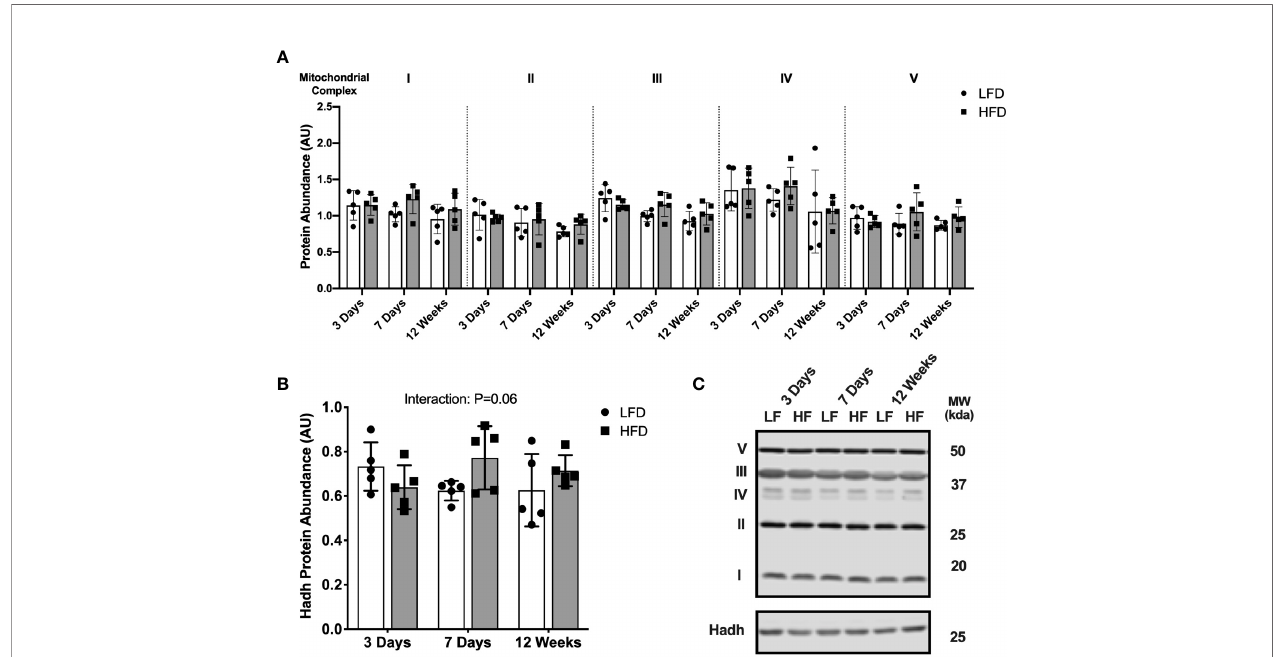
FIGURE 2 | Short-term high-fat feeding did not alter mitochondrial enzyme abundance. Immunoblotting of lysates from quadricep muscle collected after a 4-hour fast from mice fed low-fat diet or high-fat diet for 3 days, 7 days, or 12 weeks. (A) Protein abundance of subunits in mitochondrial respiratory complexes I-V expressed in arbitrary units. (B) Hadh protein abundance in tissue lysates. (C) Representative blot images for (A, B) . Data are means ± SD; n=4-5. Two-way ANOVA was used to test for effects of diet and time. P values are main